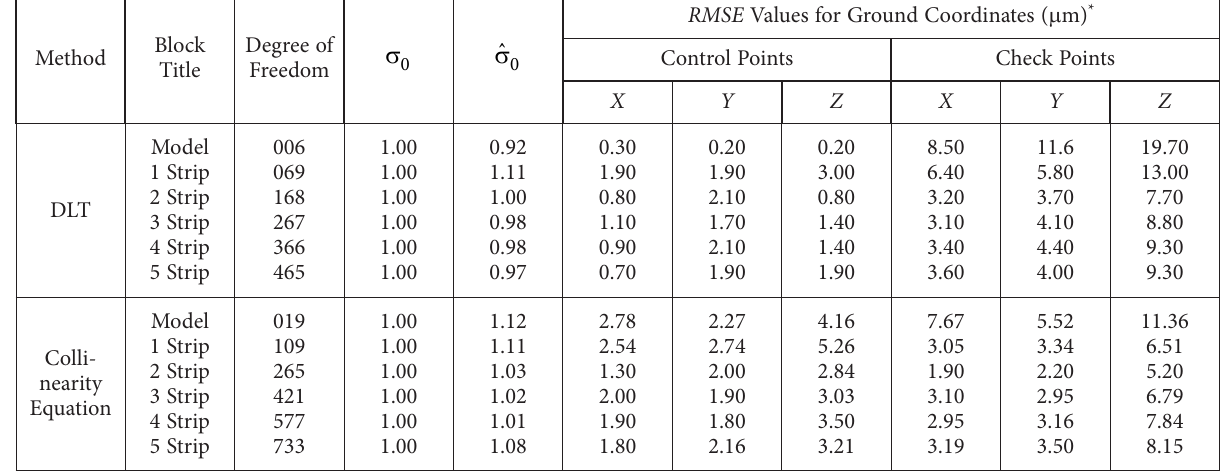
Table 3. Results of self calibration block adjustment (Case of random errors only)